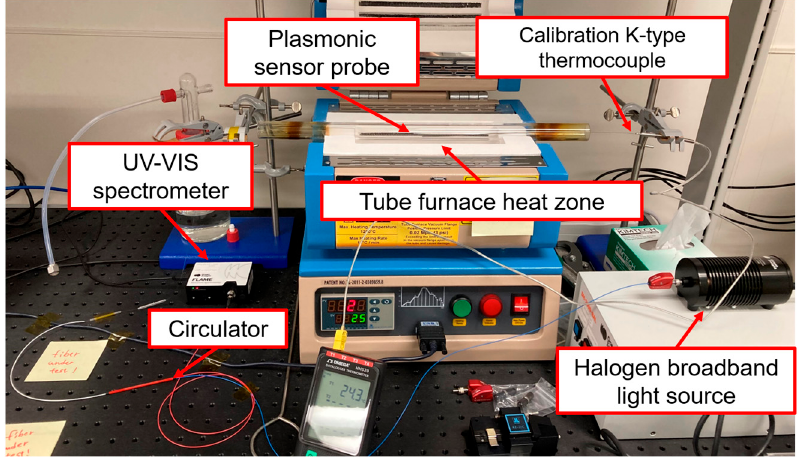
Figure 5. Experimental setup of plasmonic sensor probe temperature sensing.